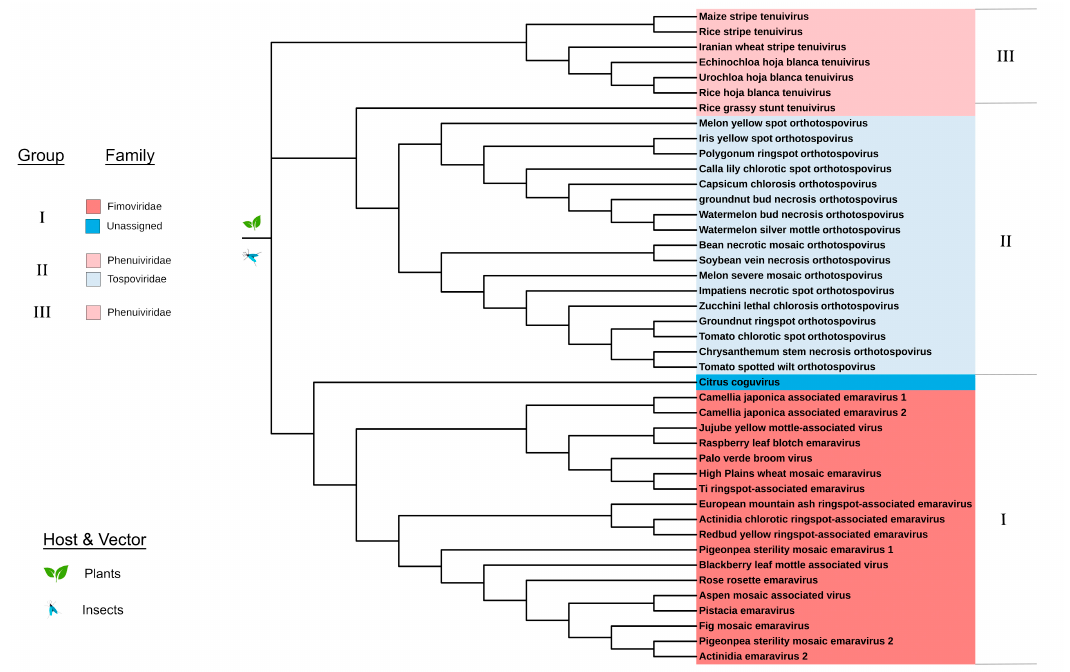
Figure 6. Maximum likelihood phylogenetic tree of the amino acid sequences of the movement protein (MP) belonging to plant viruses. Three groups were identified based on clustering from the most distant node: Group I: Fimoviridae and an unassigned species. Group II: Phenuiviridae and Tospoviridae . Group III: Phenuiviridae . All viruses of Bunyavirales with an available MP sequence have plant hosts. Clade validation is based on the aLRT-SH-like test